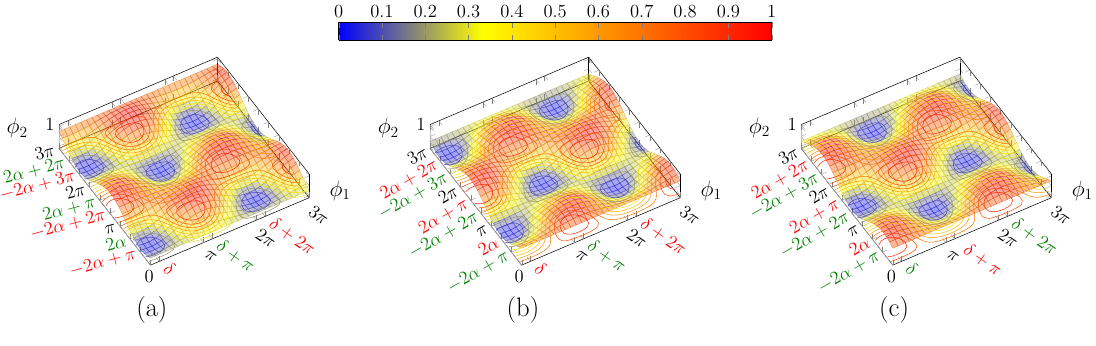
Figure 7. Plot of P L ( φ 1 , φ 2 ) for: ( a ) α = π /3 and δ = π /6; ( b ) α (cid:48) = π /2 α (cid:48) = π /2 α and δ (cid:48) = δ + π . This is the complementary surface of ( a ). Note that the two solution −